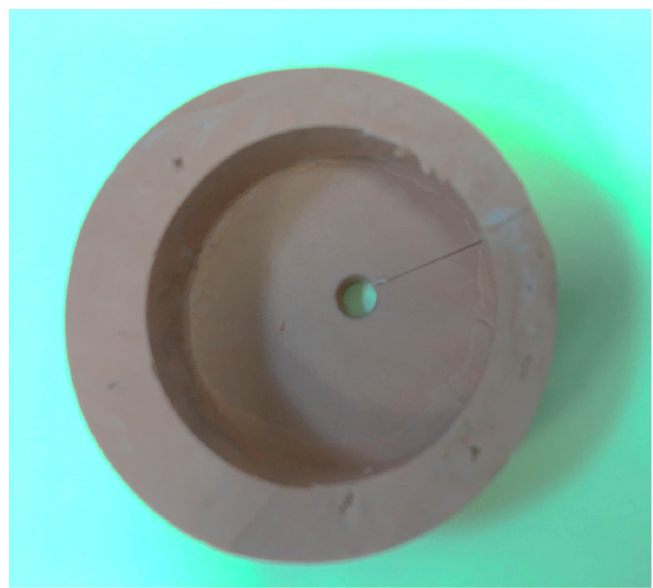
Figure 3. Custom-made additional silicone mold to standardize the composite cylinder size and location.